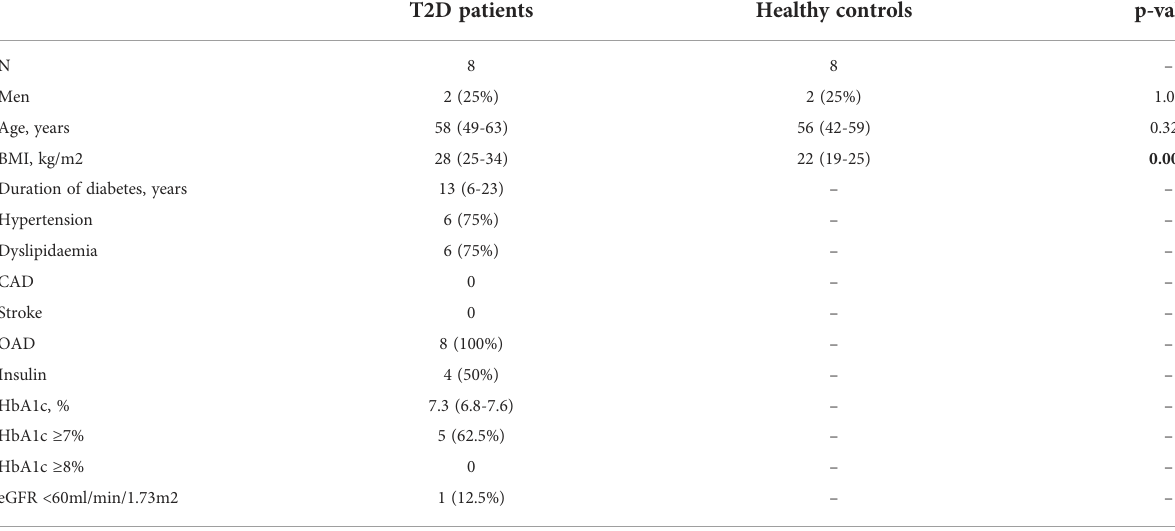
TABLE 2 Baseline characteristics of the participants in Part 2 of the study